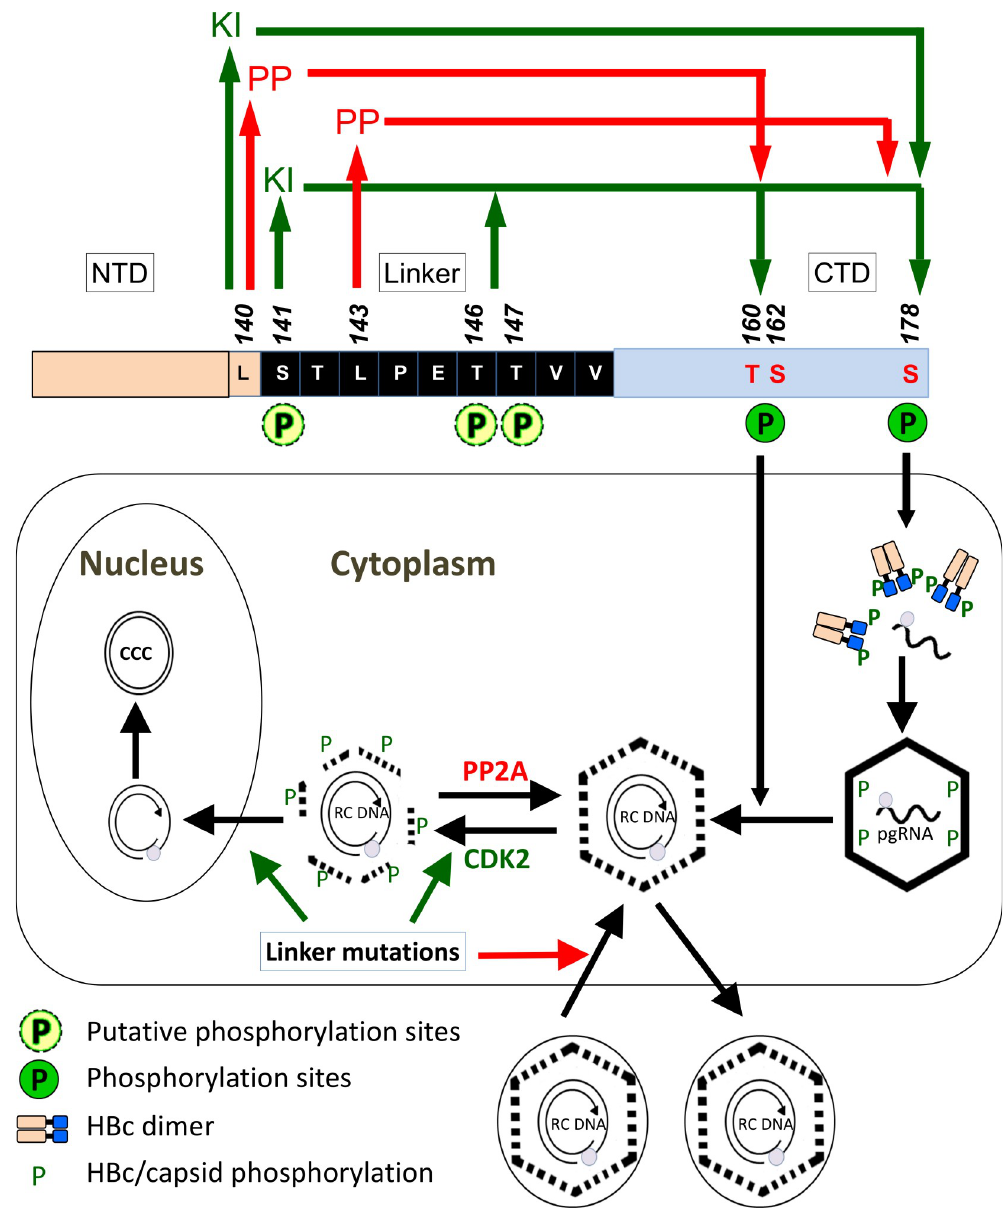
Fig 13. Model of interactions between HBc linker and host protein phosphatase (kinase) in regulating multiple steps of viral replication. The HBc domains (NTD, linker, CTD) are shown in the middle as horizontal boxes, with the linker sequence highlighted. Also highlighted are the last residue of NTD (L140, part of the PP2A-B56 consensus binding motif) and the three CTD sites where phosphorylation state was monitored in this study. The linker sequence is proposed to regulate dynamic CTD phosphorylation and dephosphorylation to control different stages of viral replication, among other mechanisms. The red and green arrows on the top denote the recruitment of cellular phosphatase (PP) and kinase (KI), respectively, by the indicated linker/NTD sites to modulate the indicated CTD phosphorylation sites. Shown at the bottom is a simplified scheme of HBV replication cycle, with the different stages affected by the different CTD phosphorylation sites and PP2A/CDK2 highlighted. The stimulatory and inhibitory effects of certain linker mutations on CCC DNA formation during intracellular amplification and infection, respectively, are denoted by the green and red arrows. See text for details.